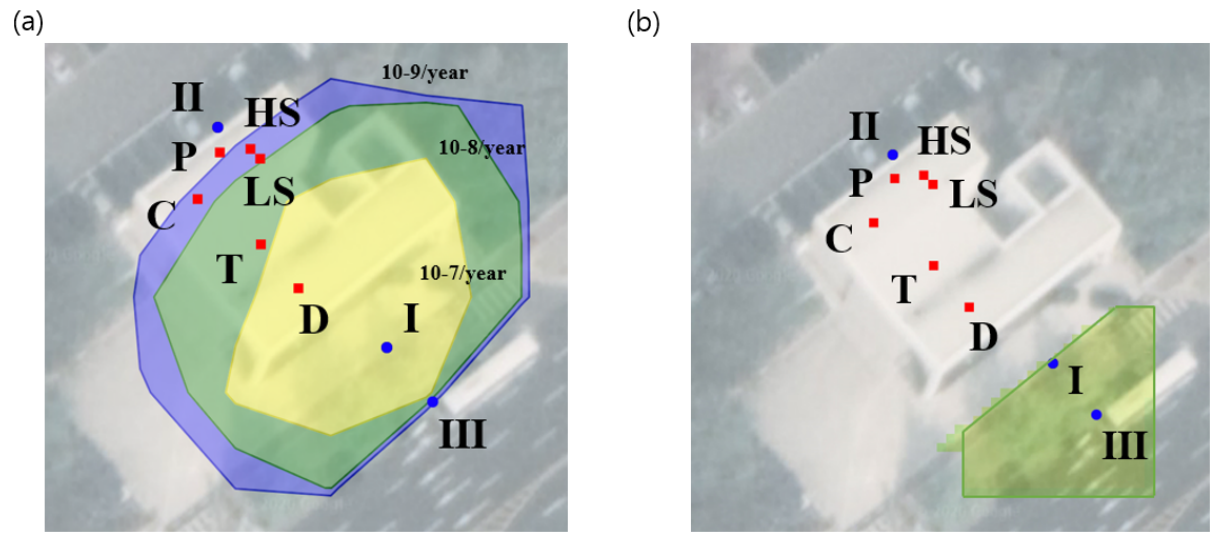
Figure 5. Analysis of societal risk according to applied to passive IPLs. ( a ) Analysis of the contribution of societal risk posed by hydrogen refueling facilities and ( b ) F–N curve analysis according to the application of passive IPLs.